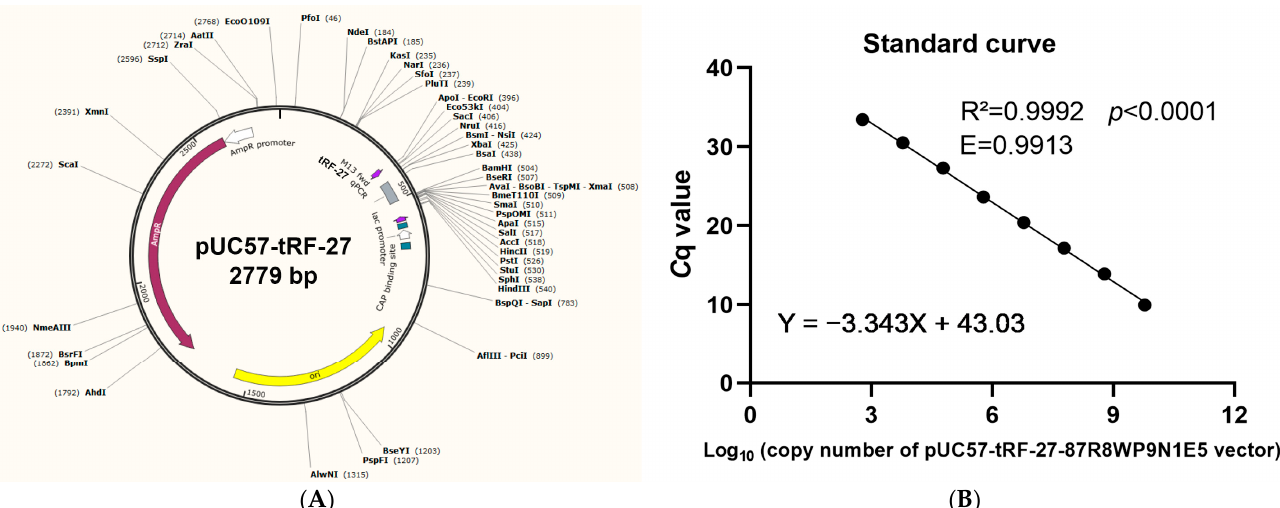
Figure 3. Standard curve used for the absolute quantification of plasma tRF-27 levels. ( A ) Map of the pUC57-tRF-27 recombinant plasmid. ( B ) Standard curve of absolute quantitation.